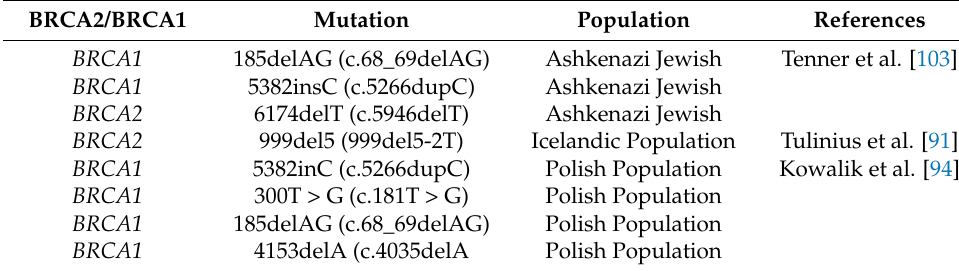
Table 3. BRCA1/2 founder